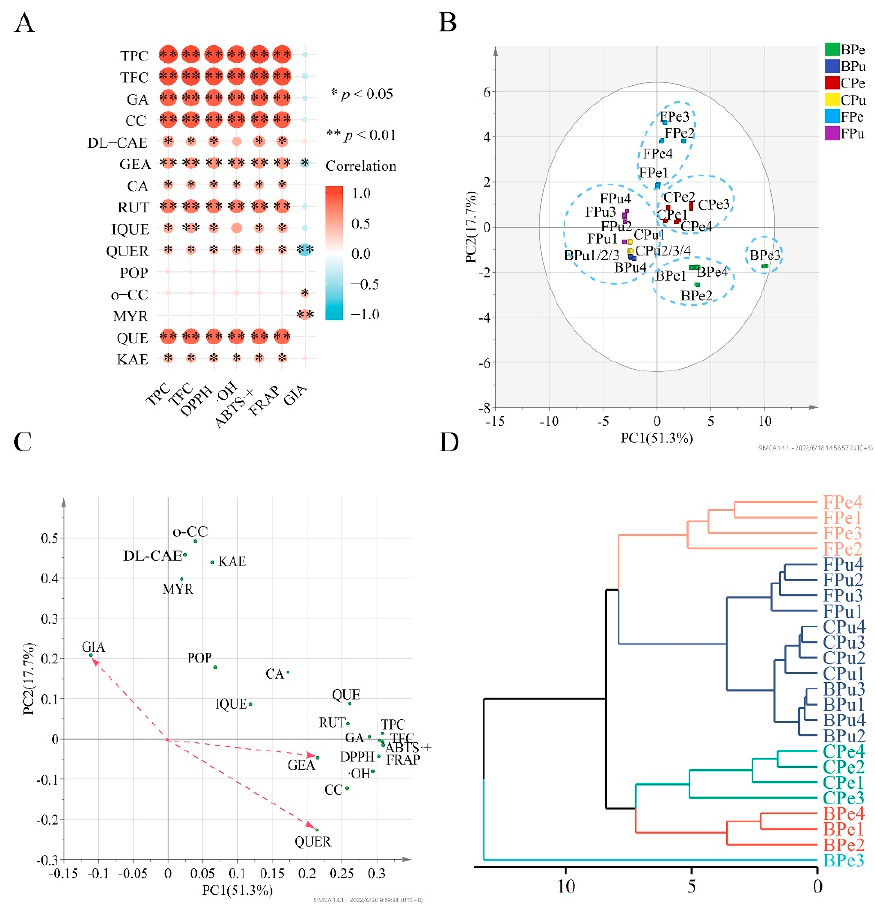
Figure 4. Correlation heatmap ( A ), PCA score plot ( B ), PC loading plot ( C ), and dendrogram ( D ) of the data matrix of the contents of individual phenolic, TPC, TFC, and bio-activities from free, conjugated, and bound phenolic fractions in the peel and pulp of different wampee samples from South China. TPC, total phenolic content; TFC, total flavonoid content; GA, gallic acid; CC, chlorogenic acid; DL-CAE, DL-catechin; GEA, gentisic acid; CA, caffeic acid; RUT, rutin; IQUE, isoquercitrin; QUER, quercitrin; POP, populnin; o-CC, o-coumaric acid; MYR, myricetin; QUE; quercetin; KAE, kaempferol; GIA, α -glucosidase inhibition; FPe/FPu, free phenolic fraction of wampee peel/pulp; CPe/CPu, conjugated phenolic fraction of wampee peel/pulp; BPe/BPu, bound phenolic fraction of wampee peel/pulp.